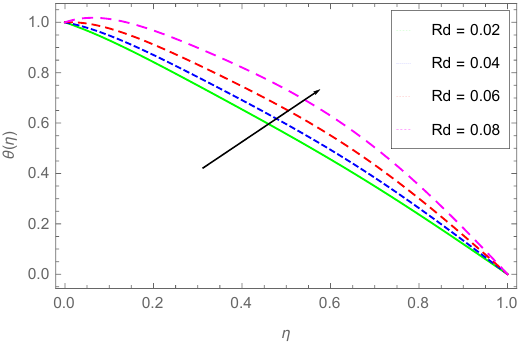
Figure 16. Impact of Rd on θ ( η )